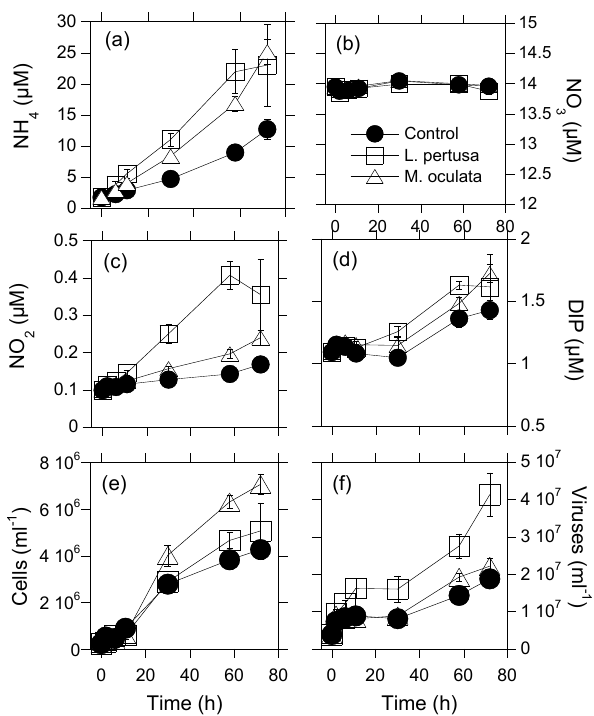
Fig. 2. Dynamics of ammonium, nitrate, nitrite and DIP concen- trations, and prokaryotic and viral abundance in experiment NSW2. Note that DIN shows the same trend as ammonium. Data are given as averages ± SE of 3 replicates. When error bars are not visible, they are within the width of the